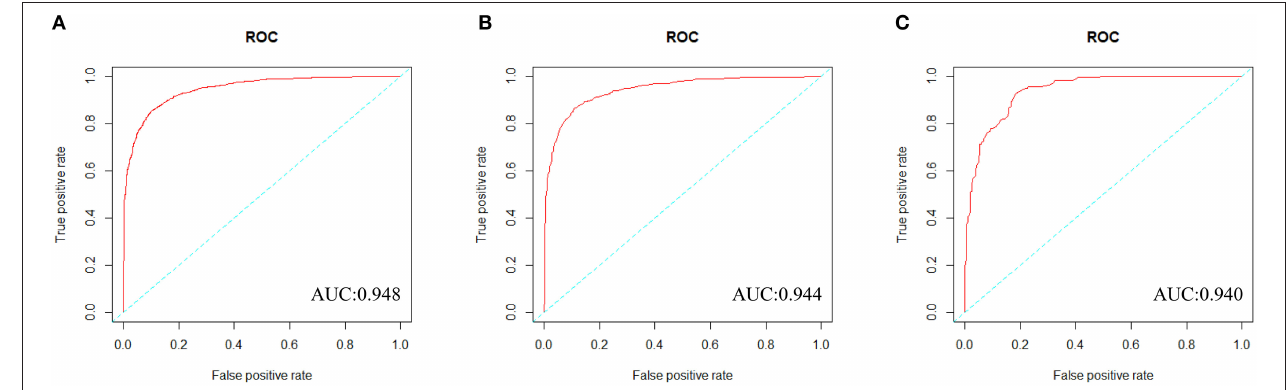
FIGURE 5 | The ROC curves of the Random Forest model in three cohorts. (A) To evaluate discrimination performance in the development cohort, area under the curve (AUC) of ROC curve was 0.948. (B) To assess the discrimination capability in the validation cohort 1, AUC was 0.944. (C) To assess the predictive capability in the validation cohort 2, AUC was